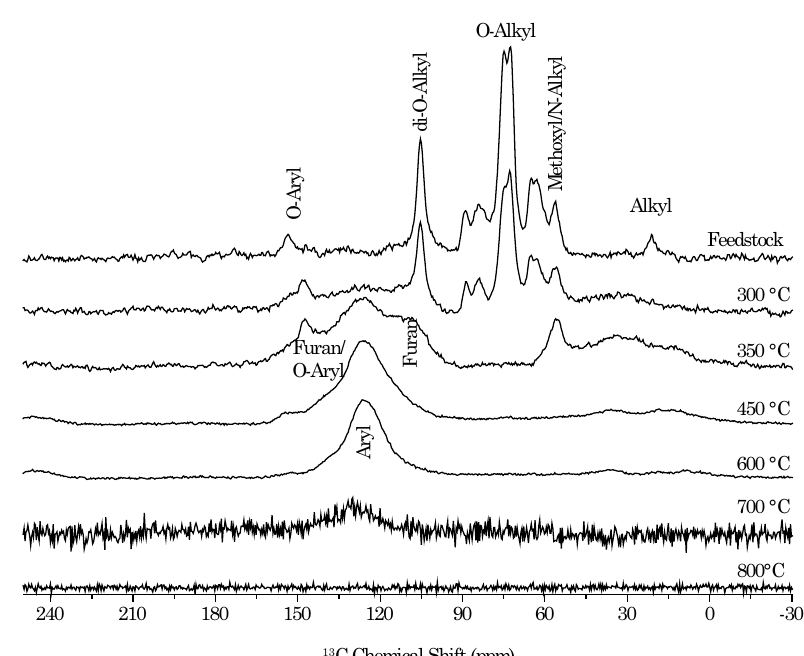
Figure 4. Cross polarization with magic angle sample spinning 13 C nuclear magnetic resonance of Eucalyptus grandis wood feedstock and its biochar at different highest heat temperature treatments (1 h carbonization). Spectra from 600 to 800 °C represent acid-insoluble coffee husk residues (Rambo et al.,